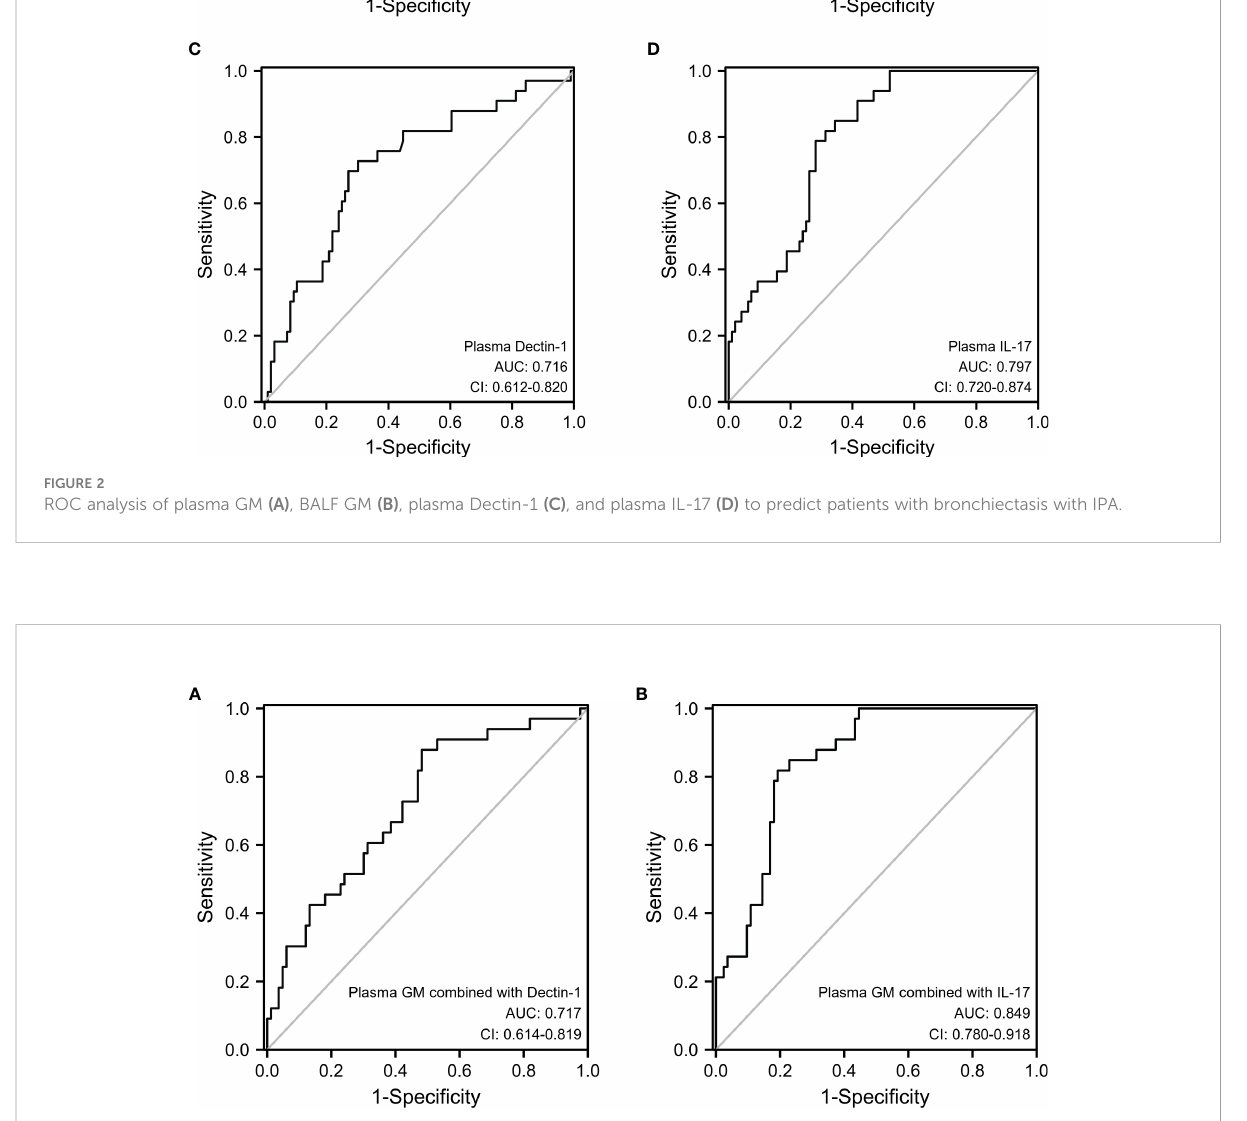
FIGURE 3 Diagnostic accuracy of combined testing of plasma GM and Dectin-1 (A) or plasma GM and IL-17 (B) .